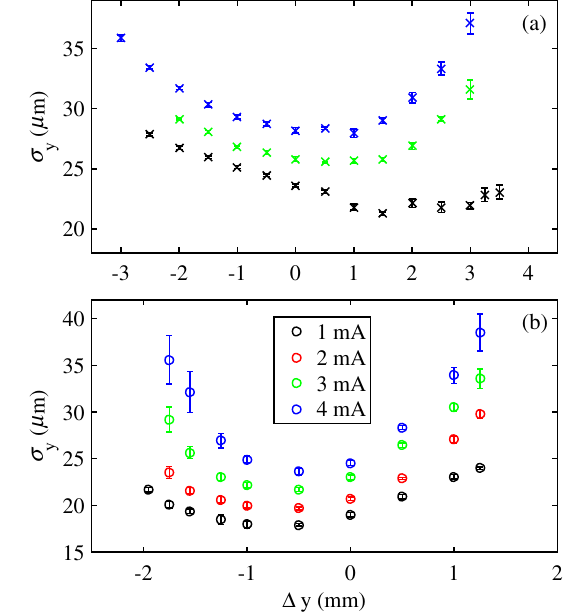
FIG. 12. The measured vertical beam size σ y as a function of the beam vertical displacement Δ y with respect to (a) the center of the scrapers and (b) the undulator chamber center at different e − bunch currents: 1 mA (black), 2 mA (red), 3 mA (green), and 4 mA (blue). The 2 mA data were not taken for the